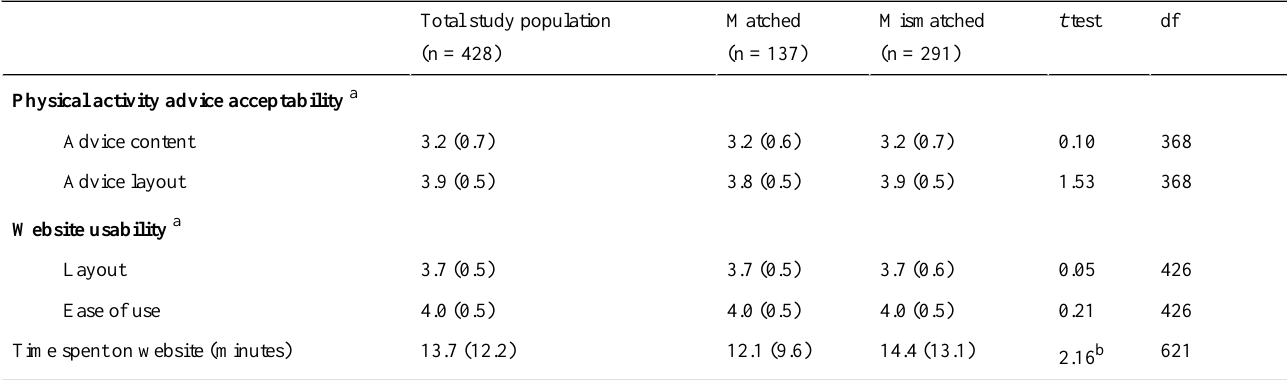
Table 4. Differences between matched and mismatched groups for acceptability of activity advice, website usability, and time spent on the website (mean,